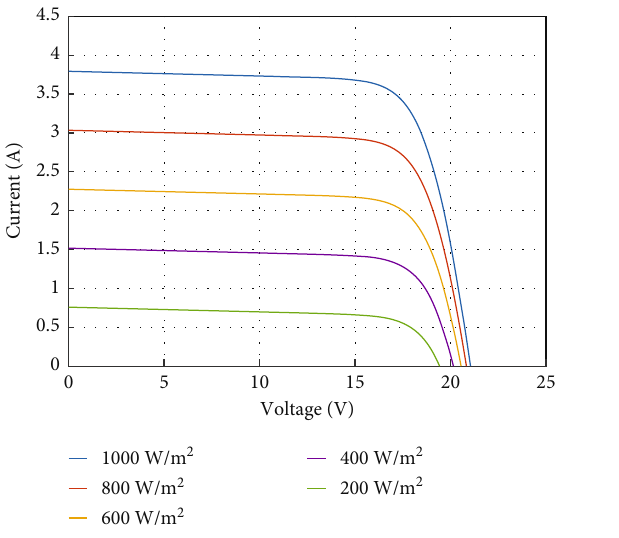
Figure 9: Irradiance e ff ect on current and voltage.